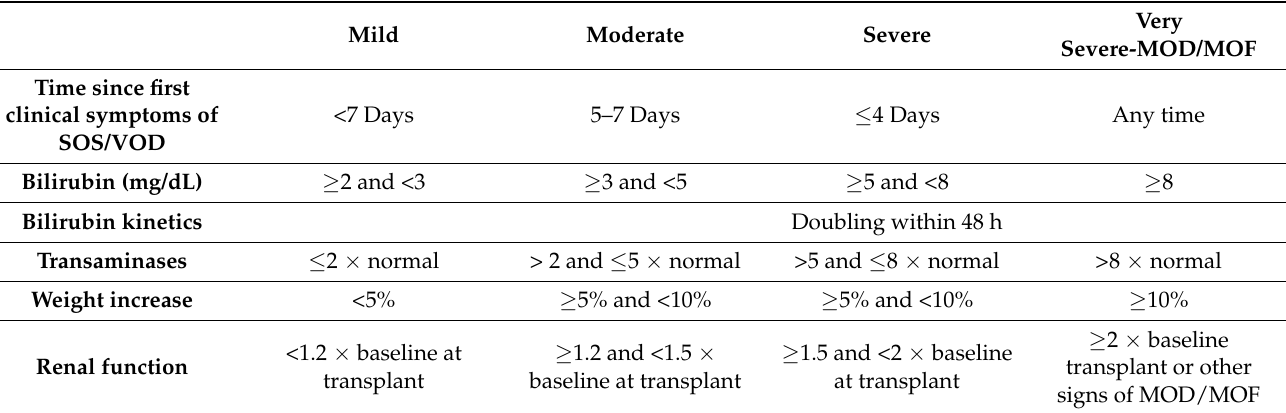
Table 2. New EBMT criteria for severity grading of a suspected SOS/VOD in adult patients. Mild Moderate Severe